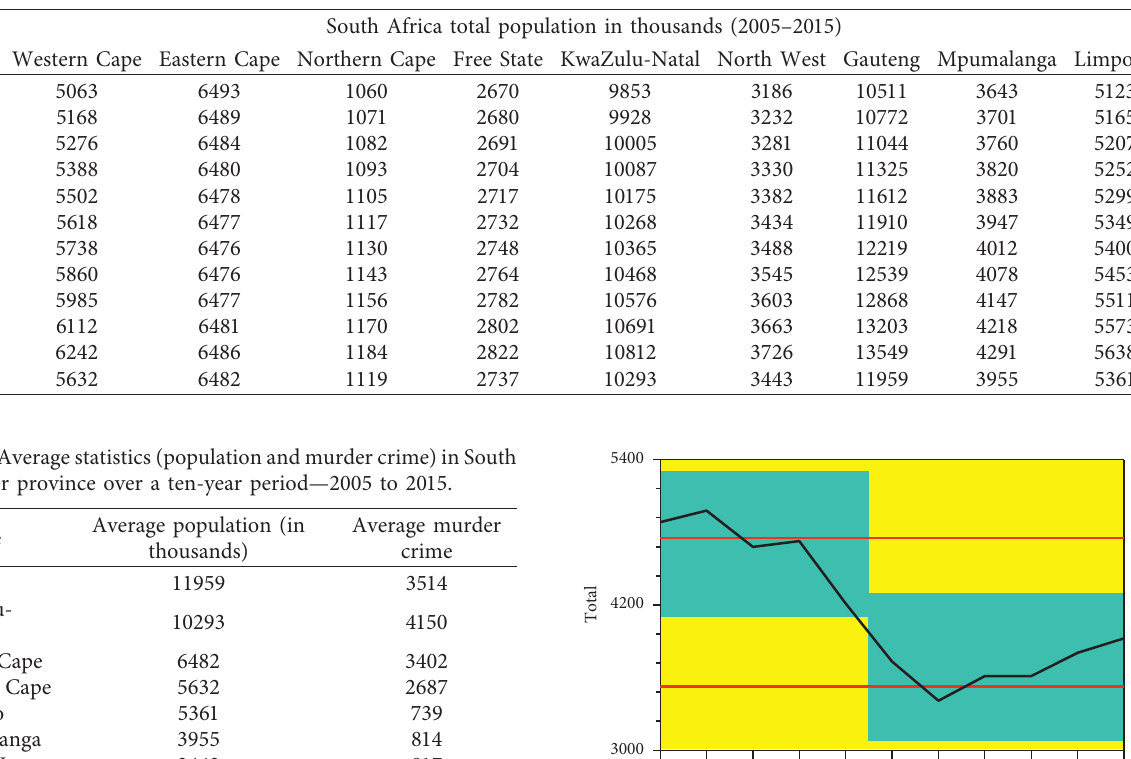
Table 2: Total population statistics in South Africa per province over a ten-year period.